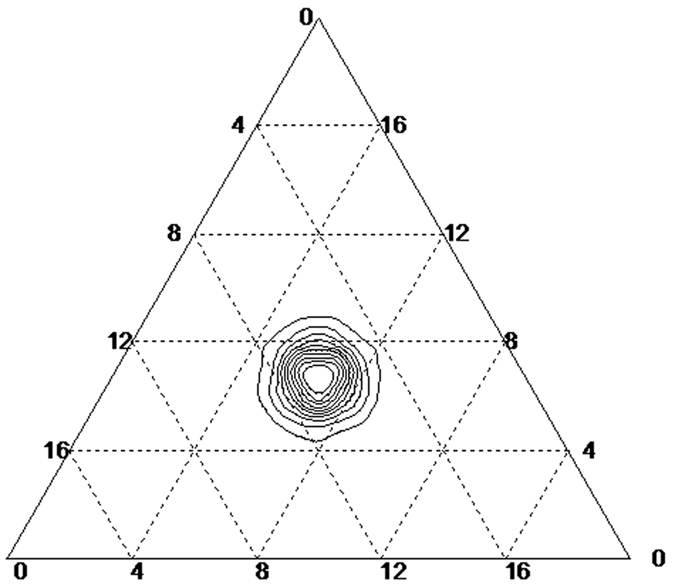
Contour diagram of the limiting distribution of the QBD process.The contour diagram of the QBD process causes the limiting distribution of the general RSP game G″ when N = 20, δ = 5 and ε = 0.01, where the contour lines mean the states have the same probability in the limiting distributions. The diagram shows that the states in the centre of the simplex have the highest probabilities.